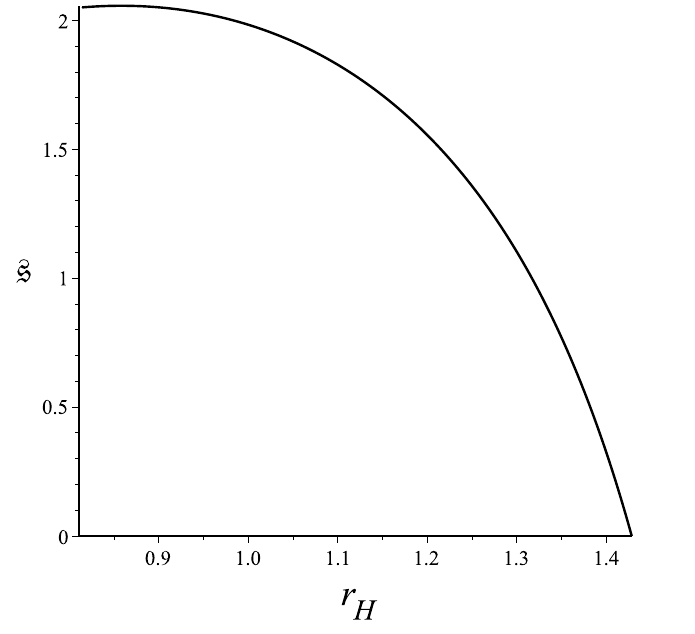
Figure 10 . Specific entropy of an AdS 5 -Kerr black hole with fixed temperature with L = 1 , as a function of r H . The domain is the physical one, corresponding to 0